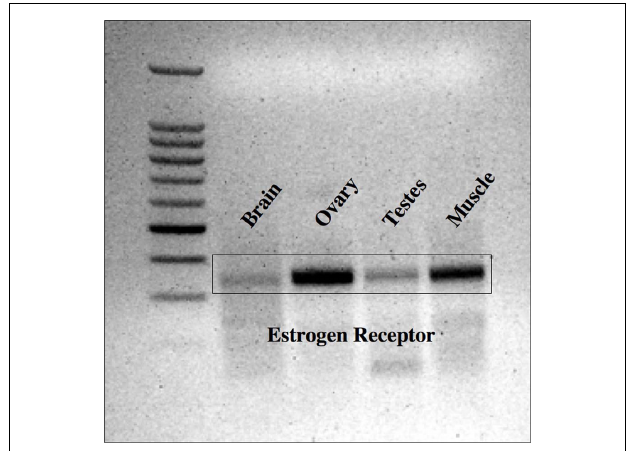
FIGURE 1 | Expression of ER in lamprey tissues. Lamprey ER was most strongly expressed in the ovarian and muscle tissues, but was also expressed in the testis and brain. 100kb ladder from Promega (Madison, WI,